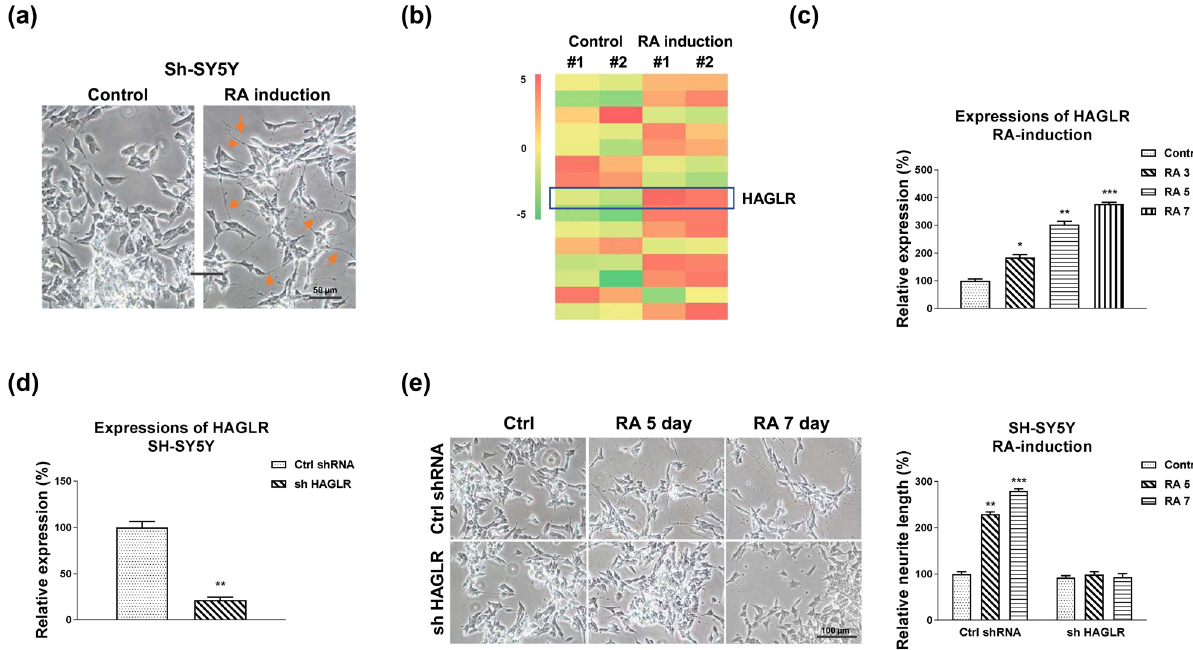
Figure 1: Roles of HAGLR in RA - induced neuron di ff erentiation. ( a ) E ff ects of RA treatment on cell morphology. SH - SY5Y cells were treated with 5 µM RA for 5 days. ( b ) SH - SY5Y cells were treated with RA using the above protocol. RNAs were isolated and lncRNA - microArray analysis was performed in duplicate. ( c ) SH - SY5Y cells were treated with 5 µM RA for 3, 5, and 7 days. HAGLR expressions were examined by qRT - PCR. ( d ) SH - SY5Y cells were transfected with control shRNA or HAGLR shRNA for 48 h, and expression of HAGLR was determined by qRT - PCR. ( e ) SH - SY5Y cells were transfected with control shRNA or HAGLR shRNA for 48 h, followed by treatments with 5 µM RA for 5 and 7 days. Cell morphologies were examined under a microscope, and the neurite length was measured. * p < 0.05; ** p < 0.01; and *** p <